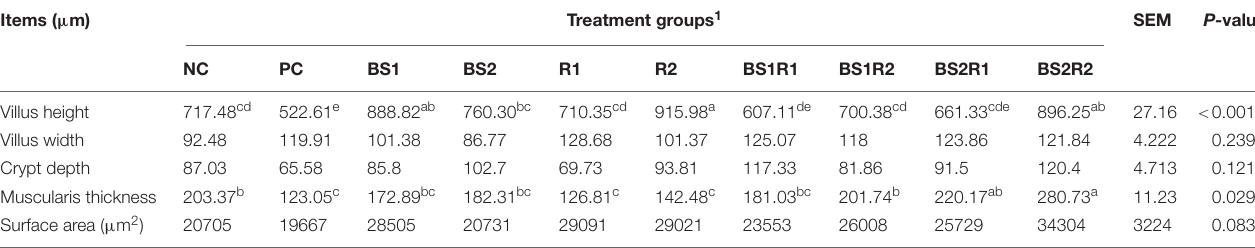
TABLE 6 | Effect of in ovo inclusion of Bacillus subtilis , raffinose, and their synbiotics on ileal morphology of 21-day-old broilers. Items ( µ m) Treatment groups 1 SEM P-